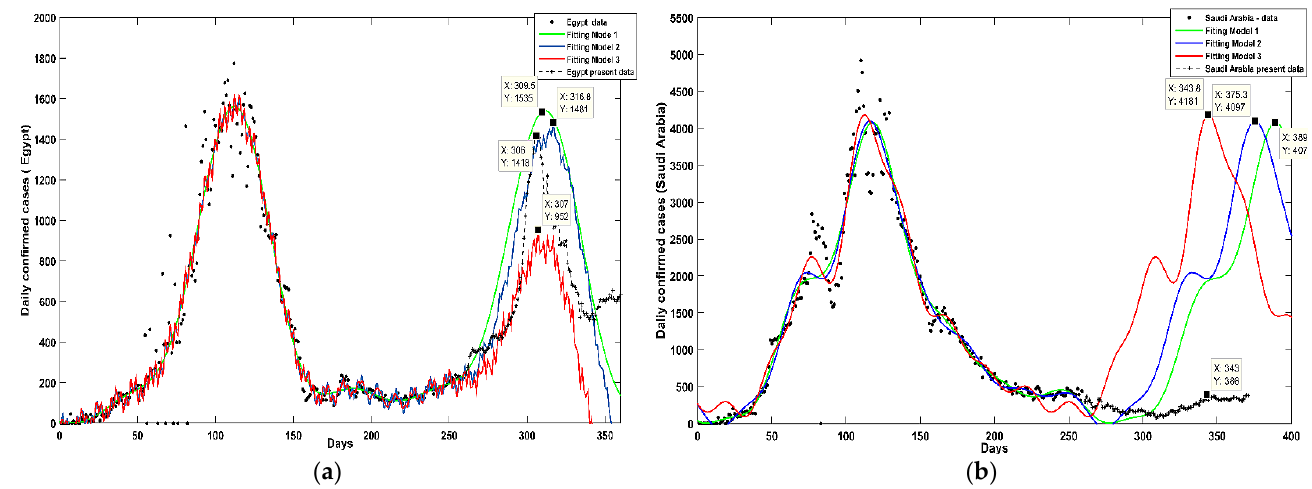
Figure 2. Curve fitting models for daily confirmed cases for first category countries: ( a ) curve fitting models for Egypt data; ( b ) curve fitting models for Saudi Arabia data.